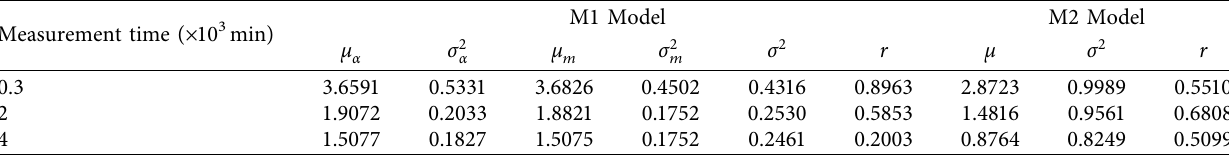
Table 2: Parameter estimation of the M1model and M2model.